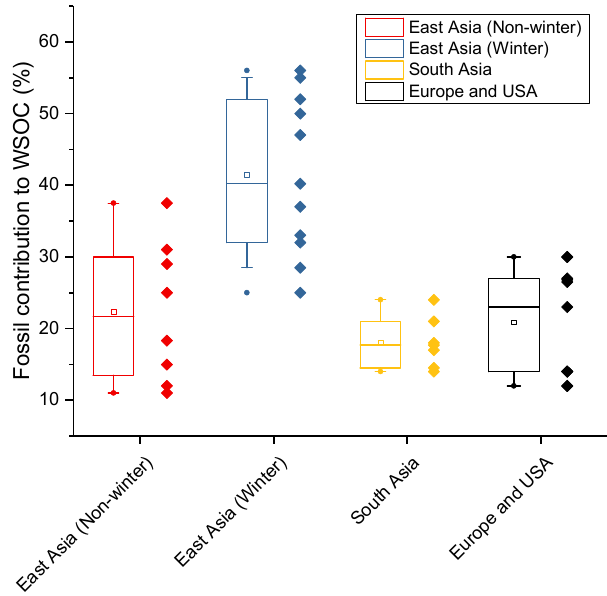
Figure 8. Box-plot of the fossil contribution (%) to the WSOC aerosols in East Asia, South Asia, the USA and Europe. The box represents the 25th (lower line), 50th (middle line) and 75th (top line) percentiles; the empty square within the box represent the mean values; the end lines of the vertical bars represent the 10th (below the box) and 90th (above the box) percentiles; the solid dots represent the maximum and minimum values; the solid diamonds represent the individual data (Table 1). The data from East Asia is grouped by winter and non-winter